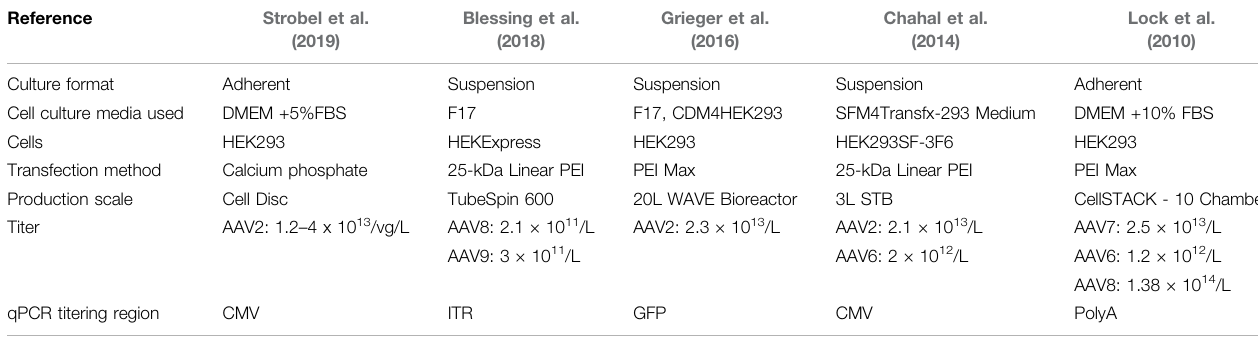
TABLE 4 | Comparison of various rAAV production